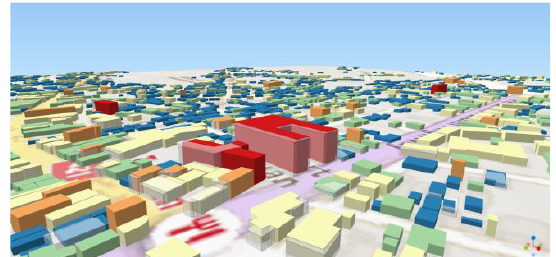
Figure 9. Models showing height and shape difference between OSM buildings and the reference test buildings.